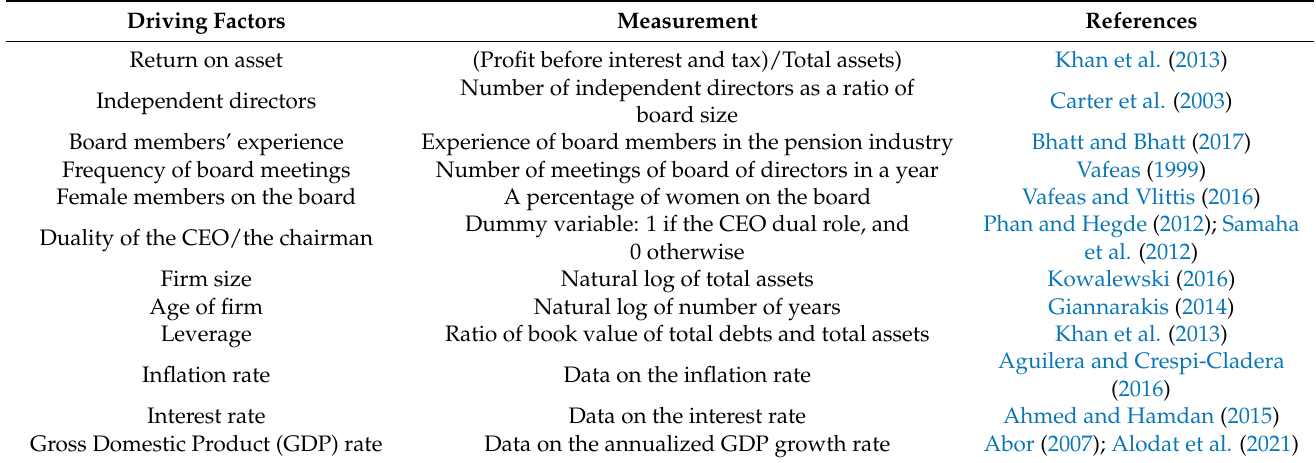
Table 1. Definition and measurement of variables of the panel regression